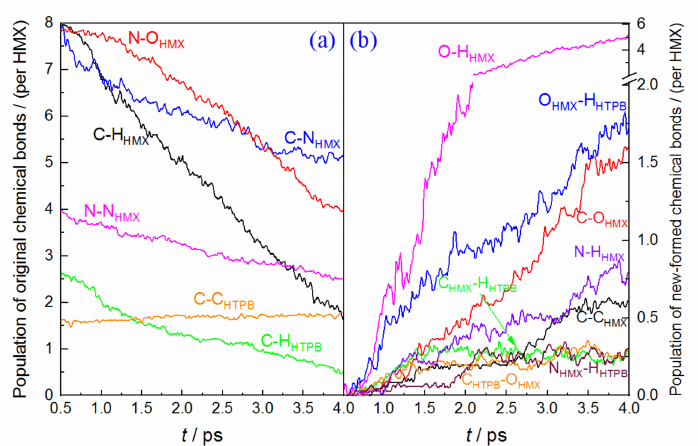
Figure 5. Time dependence of the main chemical bonds involved in HMX(010)/HTPB shock decom- position, ( a ) original chemical bonds, ( b ) new-formed